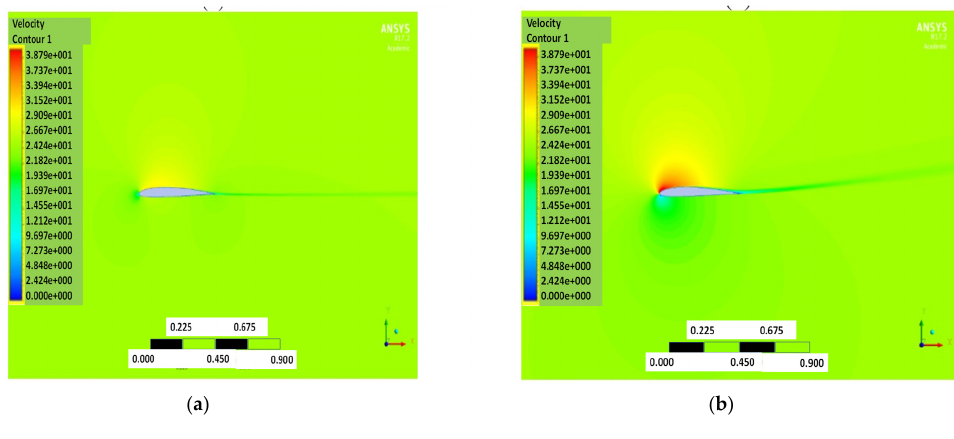
Figure 7. Pressure contour of NACA2410 with AoA ( a ) 1° and ( b ) 8°.